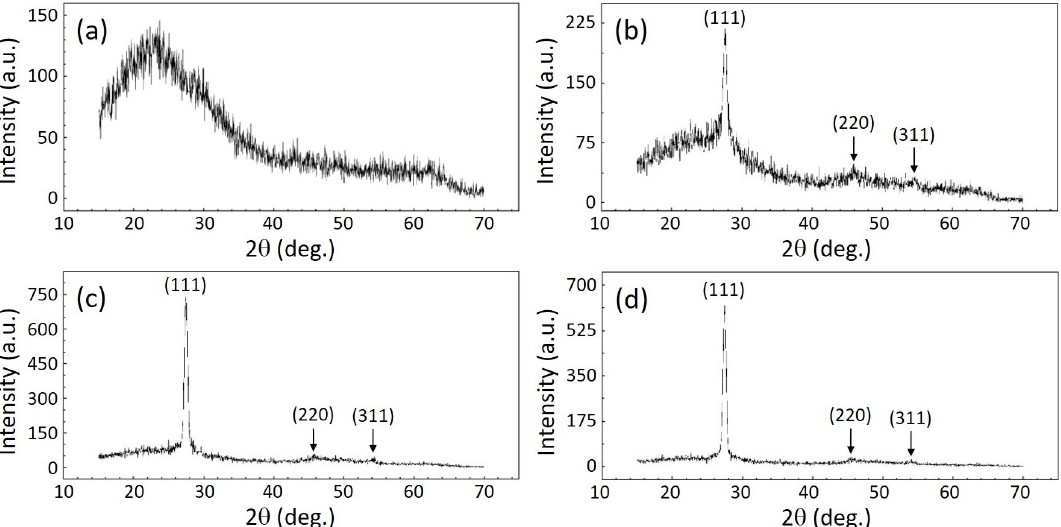
Figure 1. GIXRD patterns of the ZnSe thin films deposited by RF magnetron sputtering onto optical glass substrates at an RF power of: ( a ) 60 W, ( b ) 80 W, ( c ) 100 W, and ( d ) 120